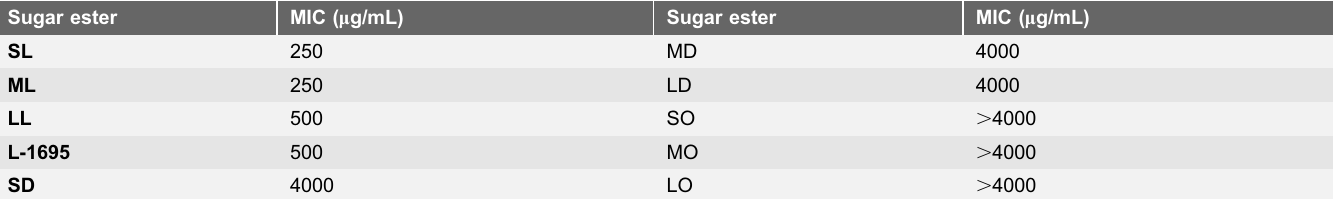
Table 4. MIC values of sugar esters for S. aureus and standards in TSB at 37 ˚ C for 24